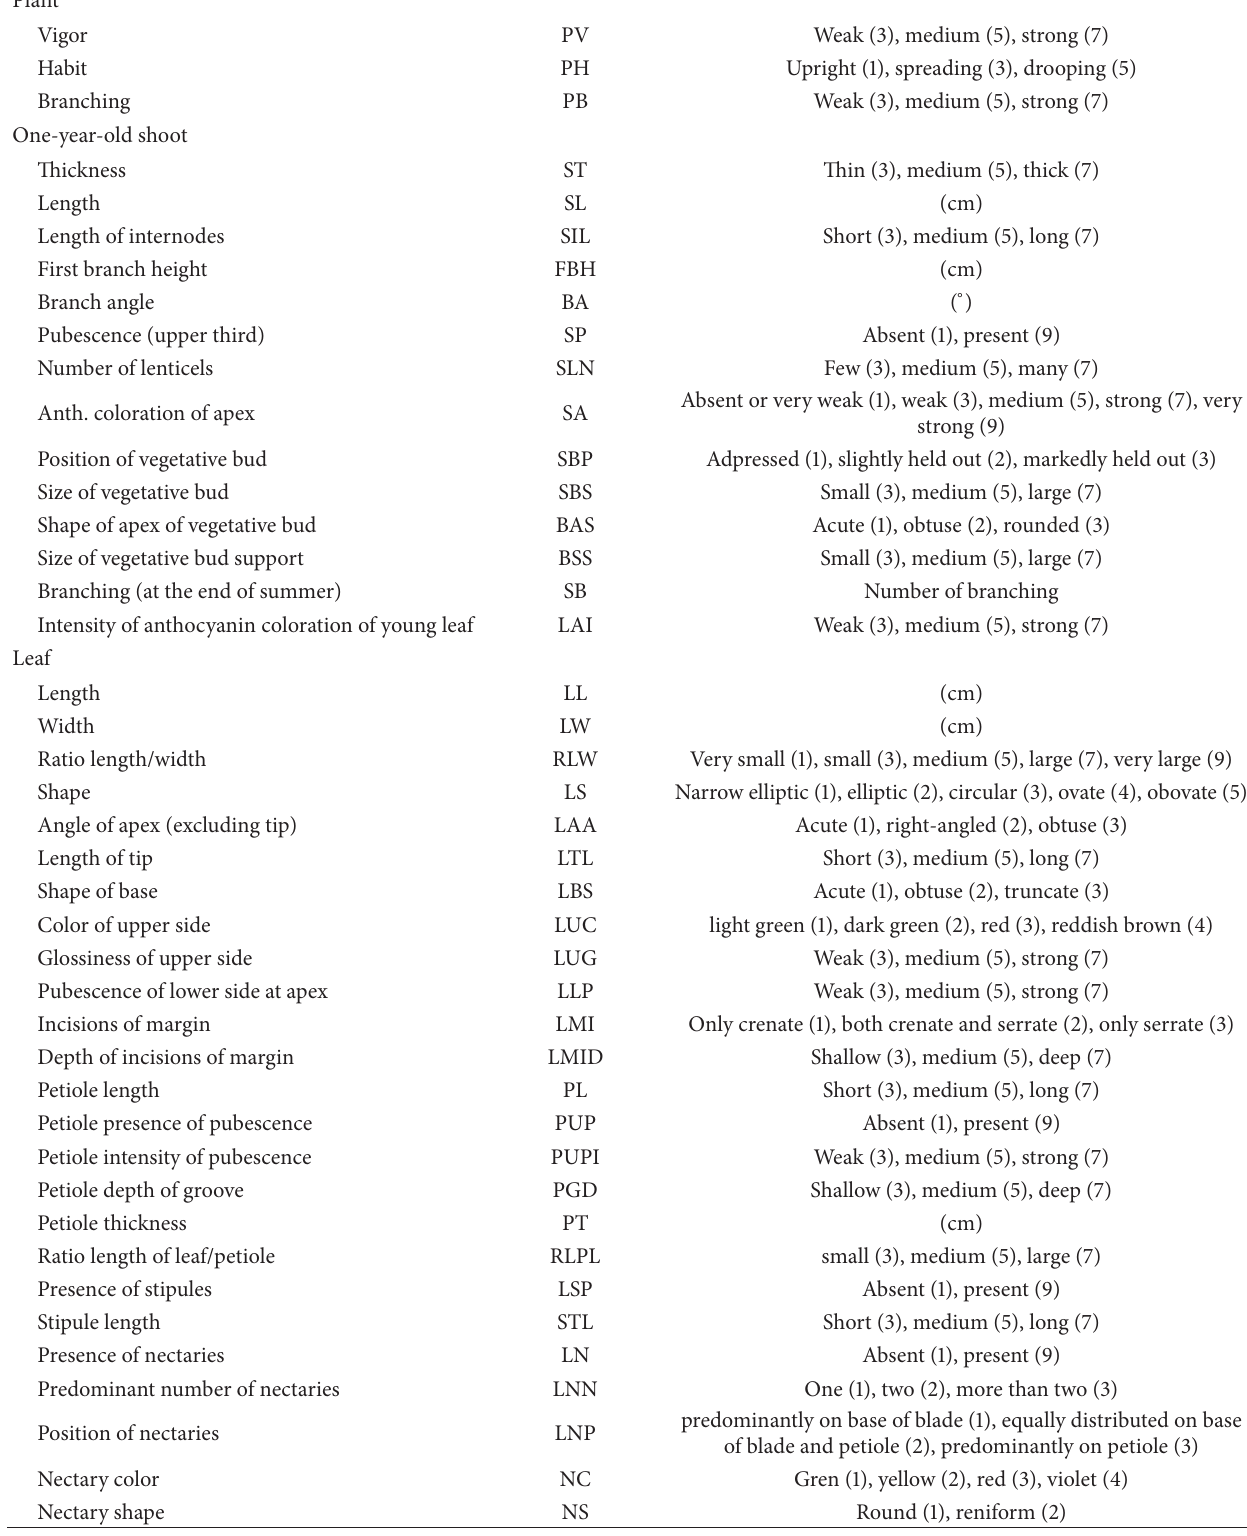
Table 2: Morphological characteristics used for the characterization of cherry